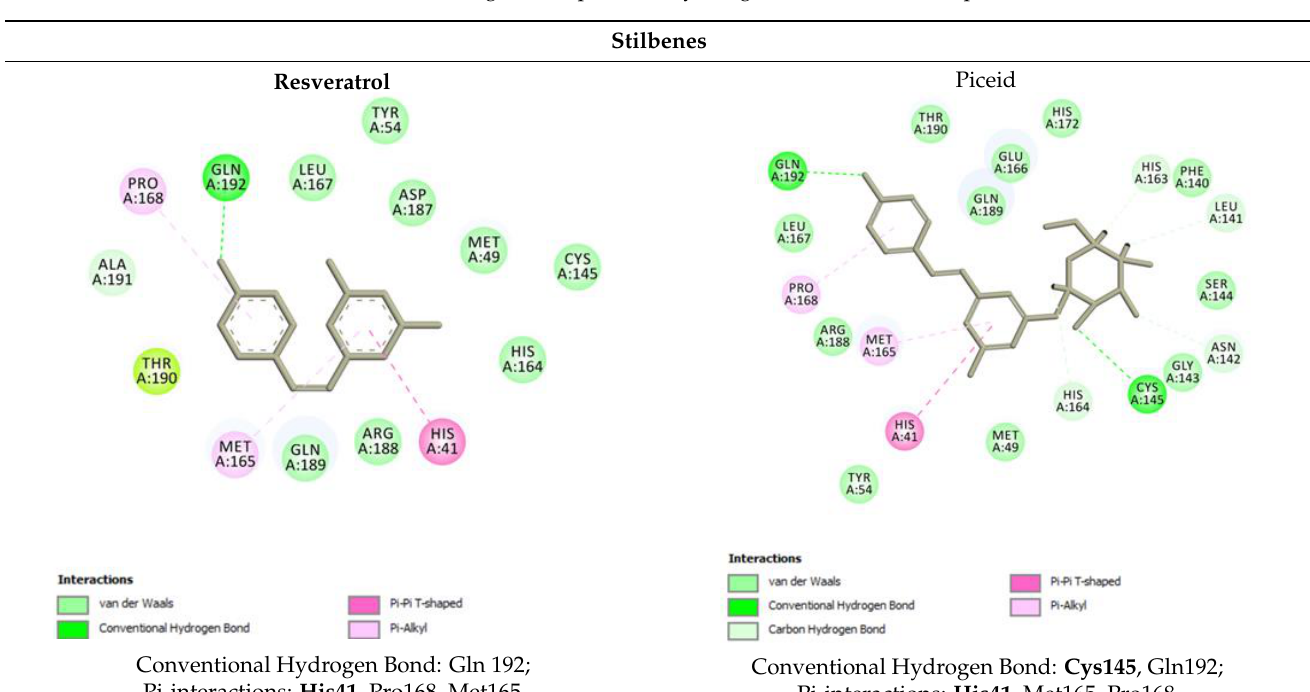
Table 2. 2D interactions diagrams of presumably not good candidates for Mpro inhibitors.